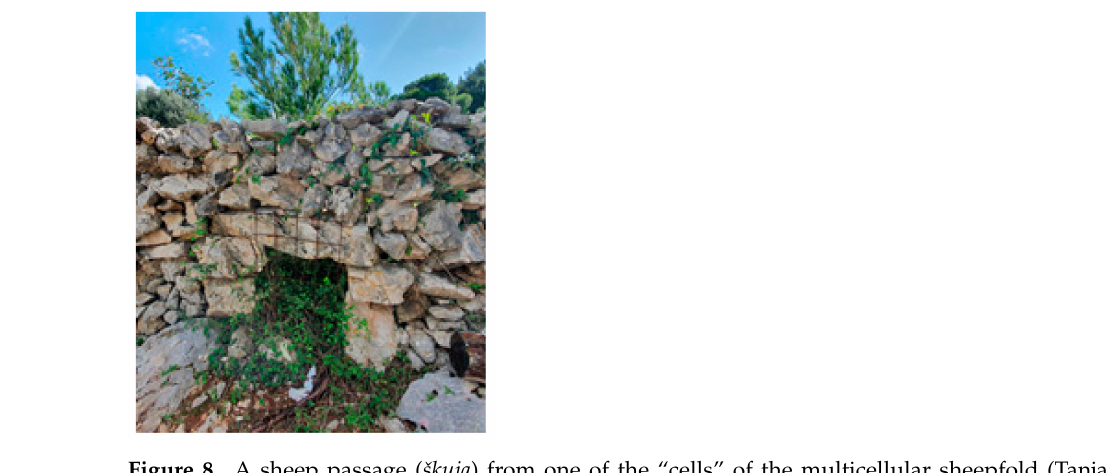
Figure 8. A sheep passage ( škuja ) from one of the “cells” of the multicellular sheepfold (Tanja Kremeni´c, 2020).